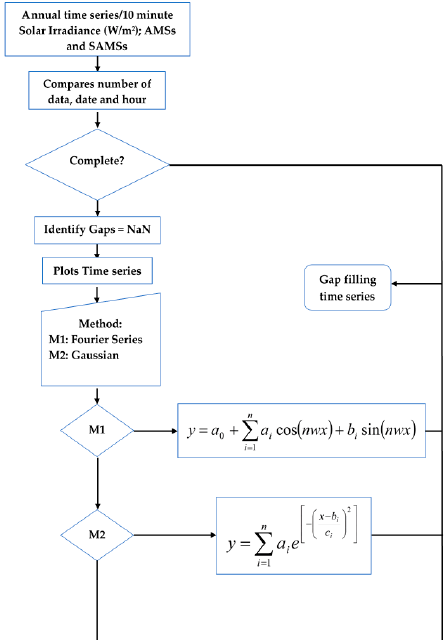
Figure 3. Gap filling algorithm. Energies 2016 , 9 , 911